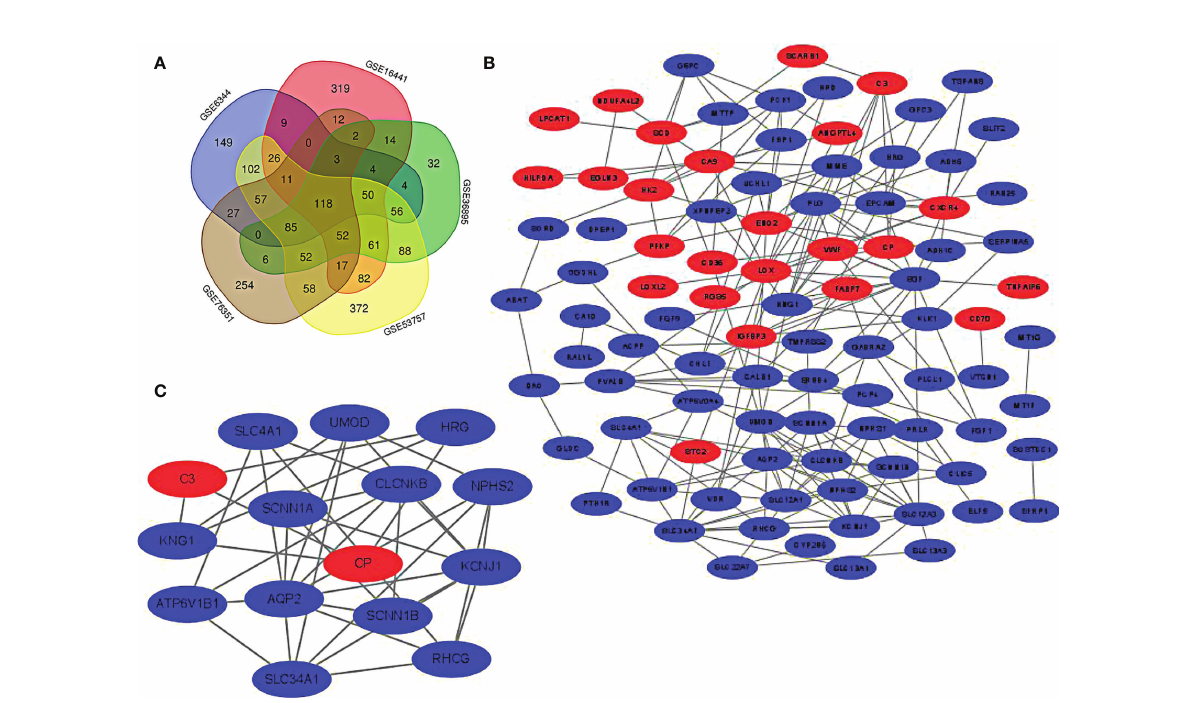
FIGURE 1 (A) screening of DEGs. The genes meeting the standard of each microarray datasets were screened. Veen diagram was made. Overlapping genes were recognized as DEGs. (B) PPI network of DEGs was constructed using Cytoscape. (C) The most statistically different module was built in PPI network through MCODE plug-in(15 nodes, 37 edges). The up-regulated gene was marked red and the down-regulated gene was marked